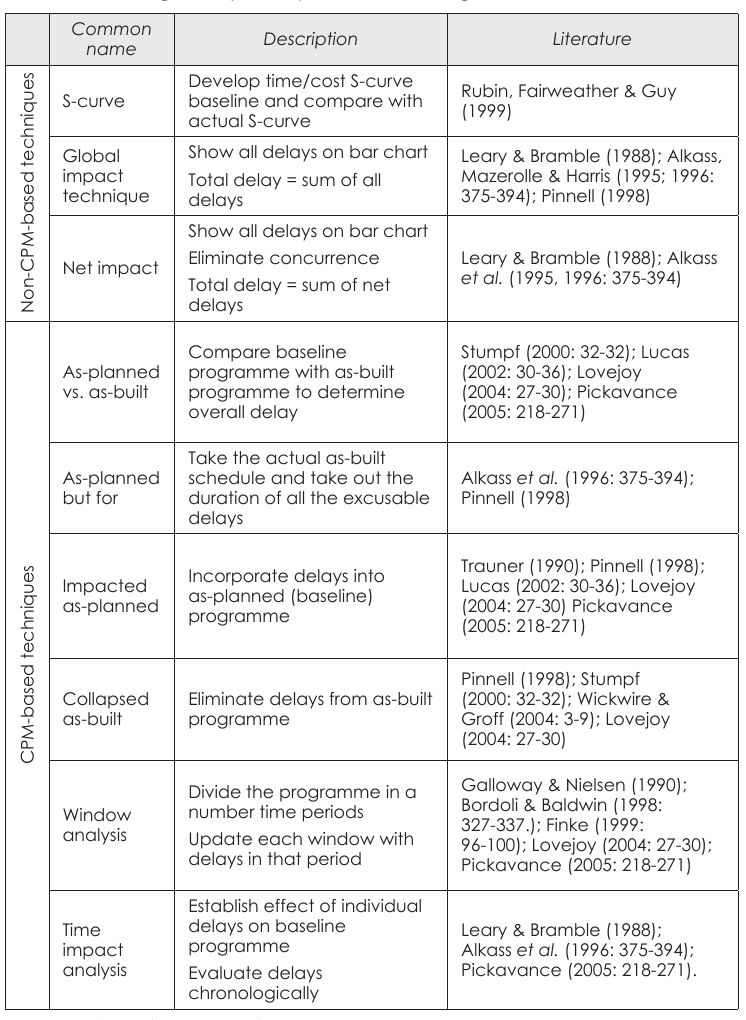
Table 1: Existing delay analysis